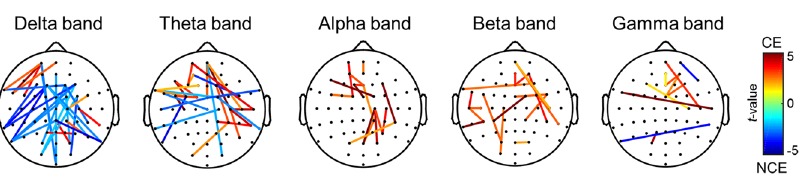
Figure 1. Differences in PLV-based connectivity between CE and NCE. Significant differences between CE and NCE are plotted ( p < 0.05, FDR-corrected). The color bars indicate the t -value of the difference between CE and NCE. Red edges indicate connections that are stronger in CE than in NCE, whereas blue edges indicate connections that are stronger in NCE than in CE. PLV = phase-locking value; FDR = false discovery rate; CE = conscious experience; NCE = no conscious